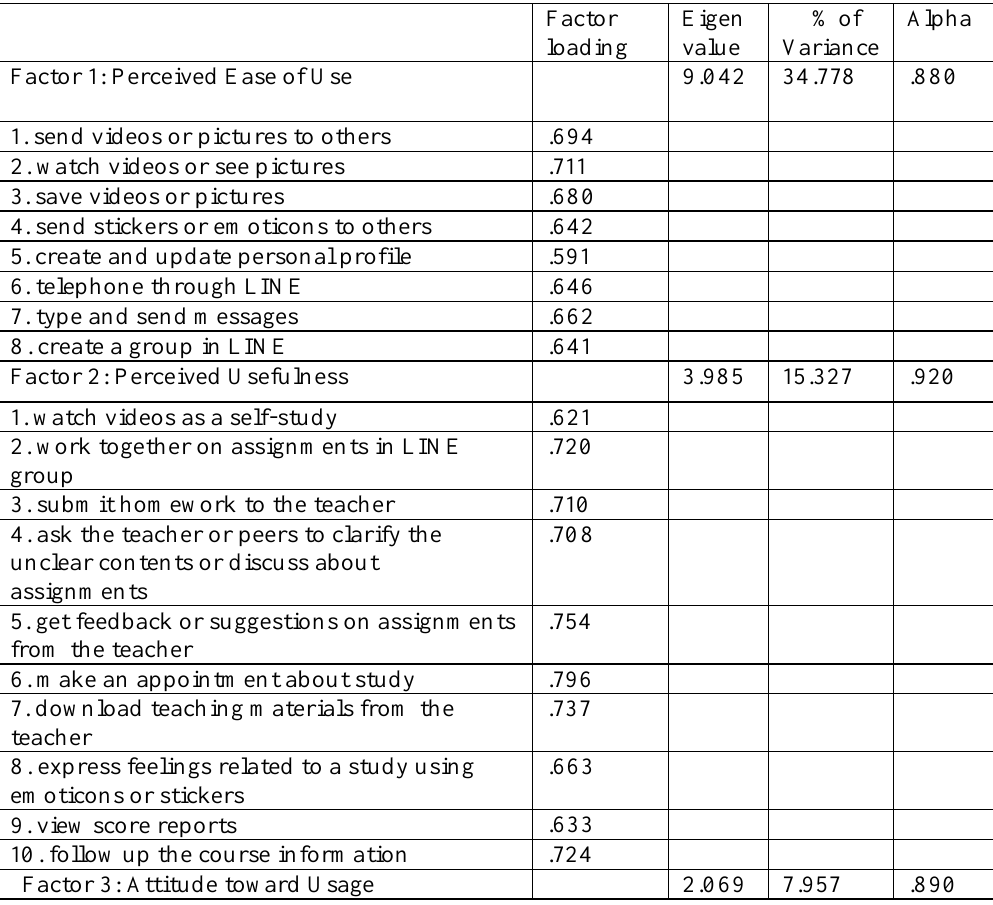
Factor Analysis of the Four